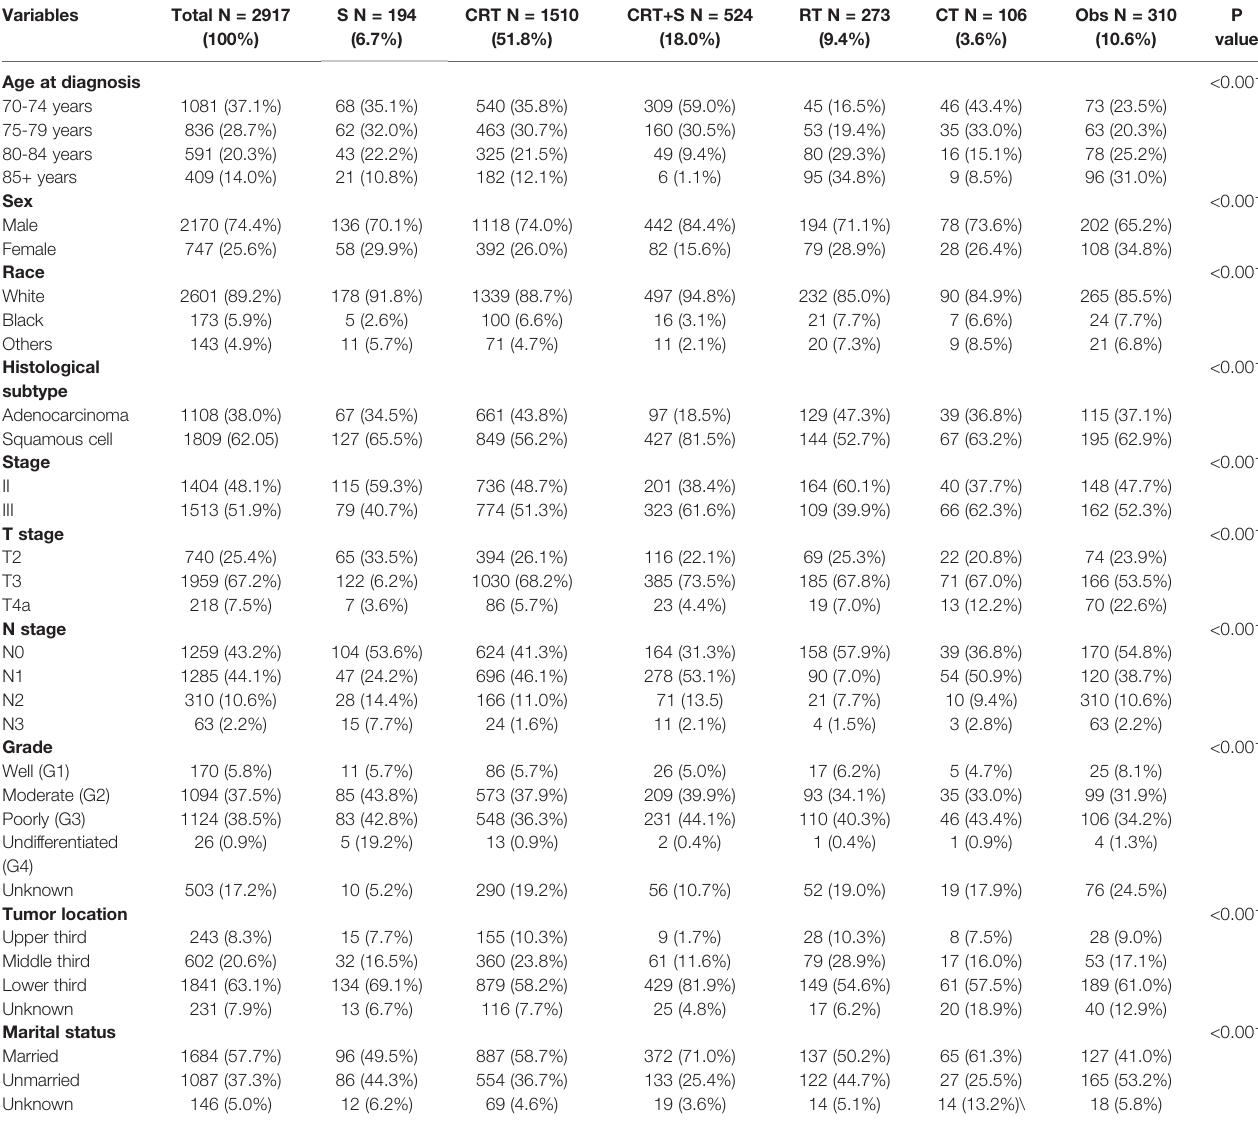
TABLE 1 | Baseline Patient Demographics and Clinical and Tumor